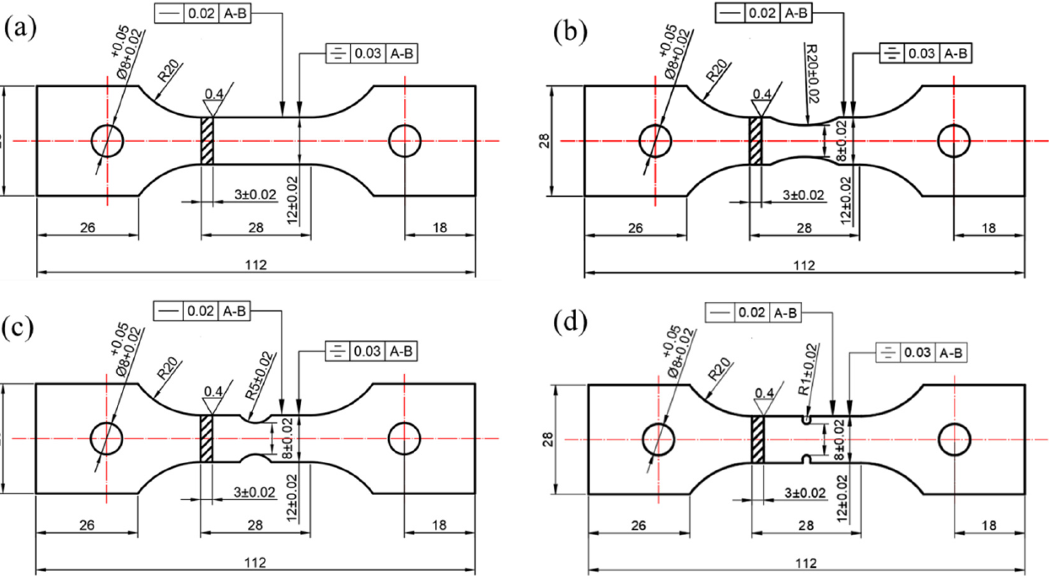
Figure 1. Metallographic structure of GH4169: ( a ) at low magnification; ( b ) at high magnification.